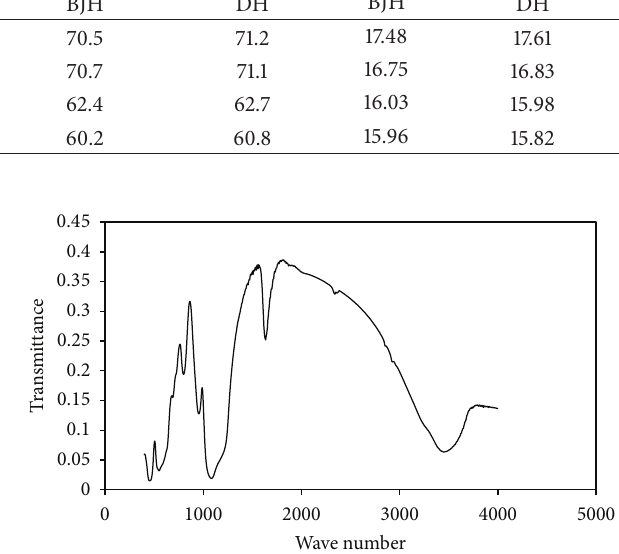
Table 2: Textural properties of the catalysts with different copper contents. Wt.% Cu